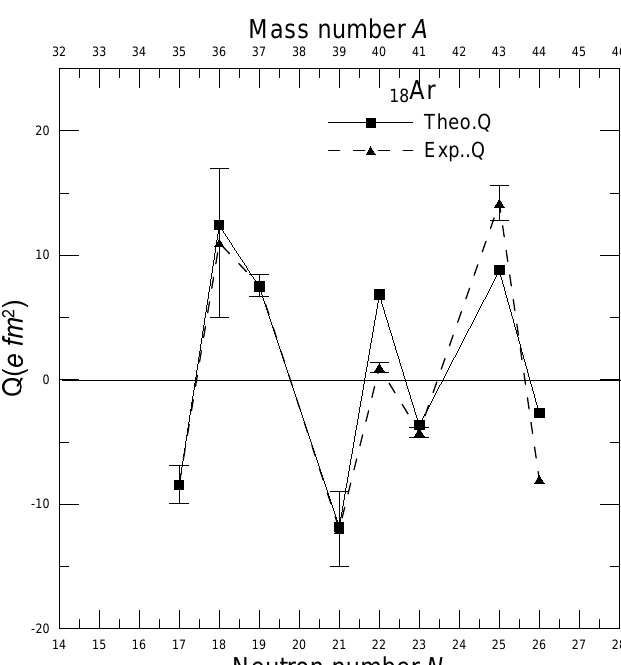
Fig. 6: Experimental [18] and theoretical quadrupole moments versus neutron number for Ar